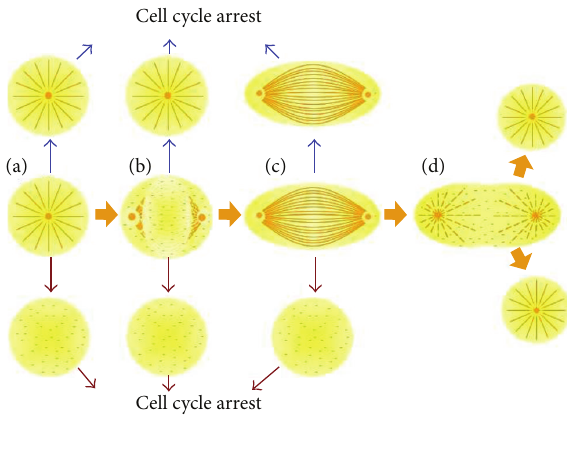
Figure 1: The dynamic nature of cytoskeleton is due to cycles of microtubule catastrophes. (a) Model structure of assembled cytoskeleton. The variety of shapes and sizes of the microtubule cytoskeleton is as great as the number of different cell types. In interphase, microtubules are long and stable because there are almost no catastrophes. (b) In mitosis, catastrophes are relatively frequent, resulting in highly dynamic microtubules that reach a steady-state length after a few minutes of growth (c). (d) After the segregation of chromatids, a new cycle of depolymerization and polymerization begins, resulting in a new stable microtubule cytoskeleton in daughter’s cells (d). Blue and red arrows indicate effects of stabilizing and destabilizing agents, all resulting in cell cycle